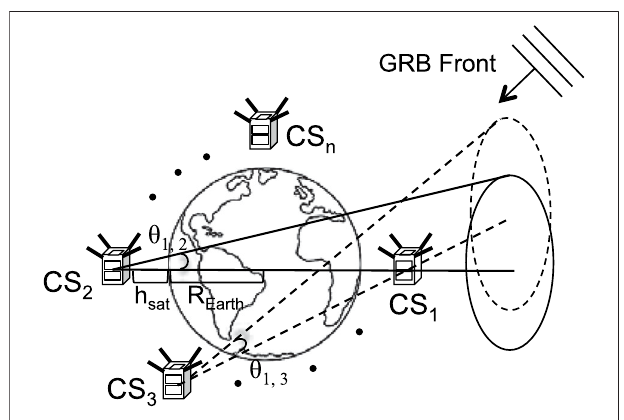
FIGURE1| IllustrationofthetriangulationmethodusingCubeSats.Each independentCubeSatpairisusedtoderiveanannulusoflocationfortheGRB